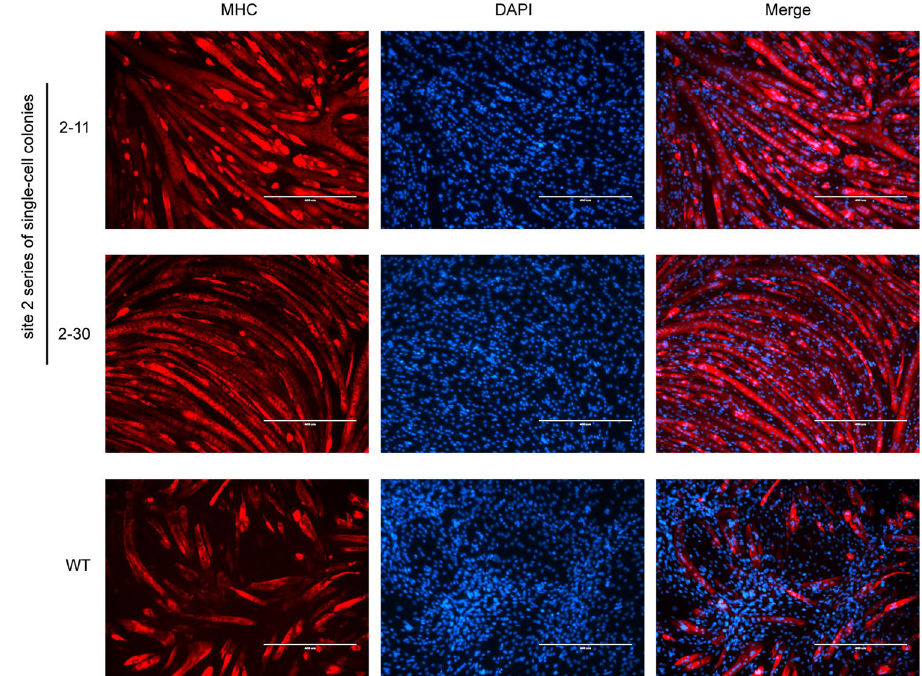
Figure 4. Detection of the muscle hypertrophy phenotype in the site 2 series of single-cell colonies. Immunofluorescence staining of MHC in myotubes of the site 2 series of single-cell colonies and the C2C12 WT control.